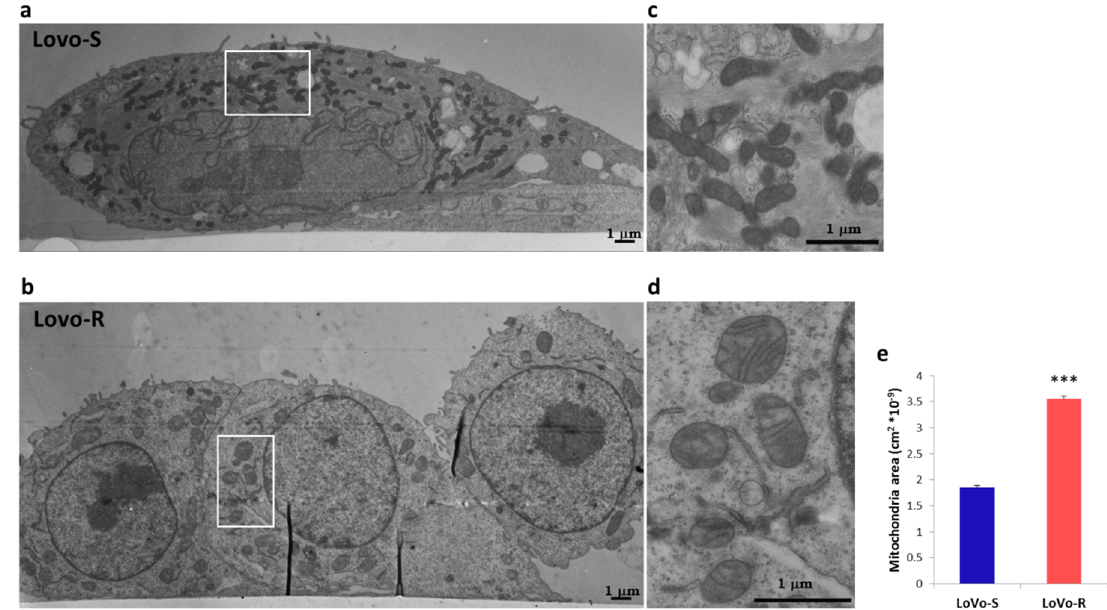
Figure 2. 2D Ultrastructure analysis of LoVo-S and LoVo-R mitochondria by electron microscopy. Electron microscopy micrographs showing LoVo-S ( a , c ) and Lovo-R ( b , d ) cells cultured in a 2D-monolayer. LoVo-S are flattened cell adhering to the plastic dish and partially overlapping ( a ), while LoVo-R exhibit a round shape and a weak relationship with the substrate ( b ). A greater enlargement ( c ) of the outlined areas of the figure ( a ) that indicate LoVo-S mitochondria with preserved ultrastructure and electrondense matrix. A greater enlargement ( d ) of the outlined areas of the figure ( b ) that show mitochondria with a pale matrix, disarrangement of the cristae and moderate cristolysis. In ( e ) mitochondria area was manually calculated on randomly electron micrographs. Values are expressed as mean ± SEM and compared using the Student’s t test (*** p < 0.001).